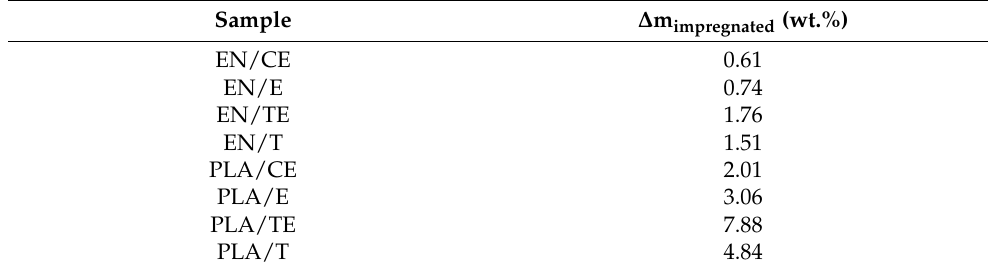
Table 1. Mass improvement of polymer samples after the impregnation process with different solutions.